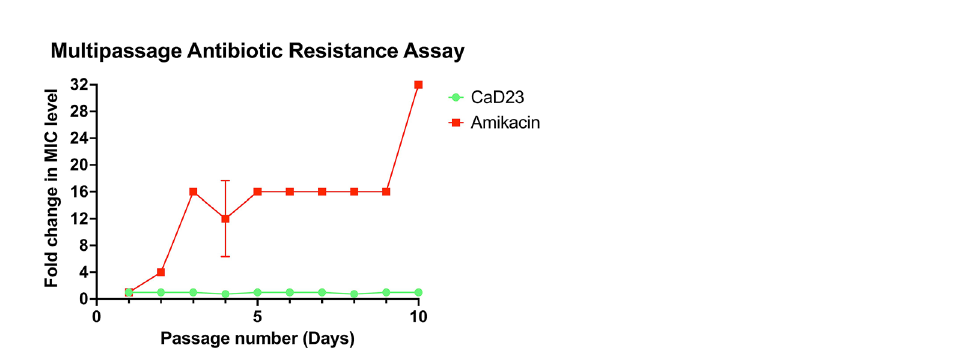
Figure 5. Multipassage antimicrobial resistance (AMR) assays for CaD23 and amikacin against S. aureus ATCC SA29213 over 10 consecutive passages (days). S. aureus did not develop any AMR against CaD23 after 10 passages whereas it developed significant AMR against amikacin, with a fourfold increase in the MIC after the 2nd passage and a 32-fold increase in the MIC after the 10th passage. Data is presented as mean ± standard deviation (depicted in error bars) of two independent experiments performed in biological duplicate. Some error bars are missing due to small or no standard deviation